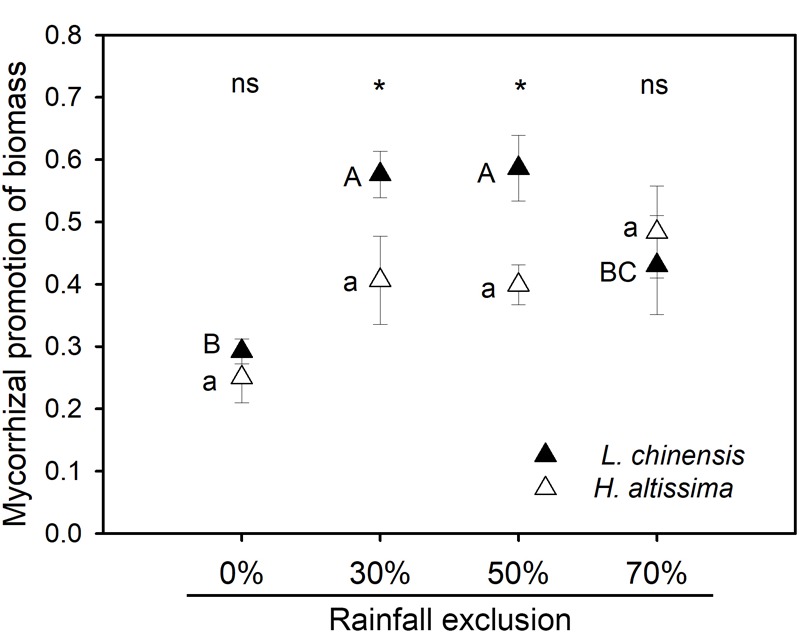
Mycorrhizal response of biomass in L. chinensis and H. altissima. Mycorrhizal benefit existed when values of mycorrhizal response were greater than zero. Different lowercase and capital letters indicate significant differences (P < 0.05) among the rainfall exclusion treatments in H. altissima and L. chinensis, respectively. ∗P < 0.05 indicates significant and ns (P > 0.05) indicates no differences between L. chinensis and H. altissima. Data are reported as mean ± 1 SE (n = 4).